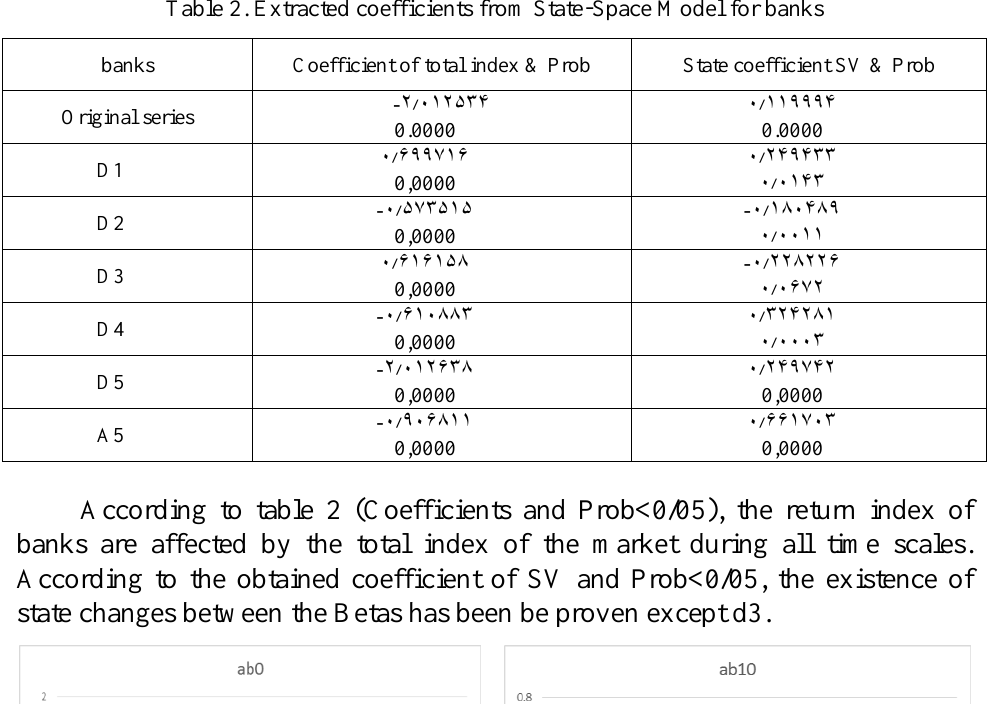
Table 2. Extracted coefficients from State-Space Model for banks